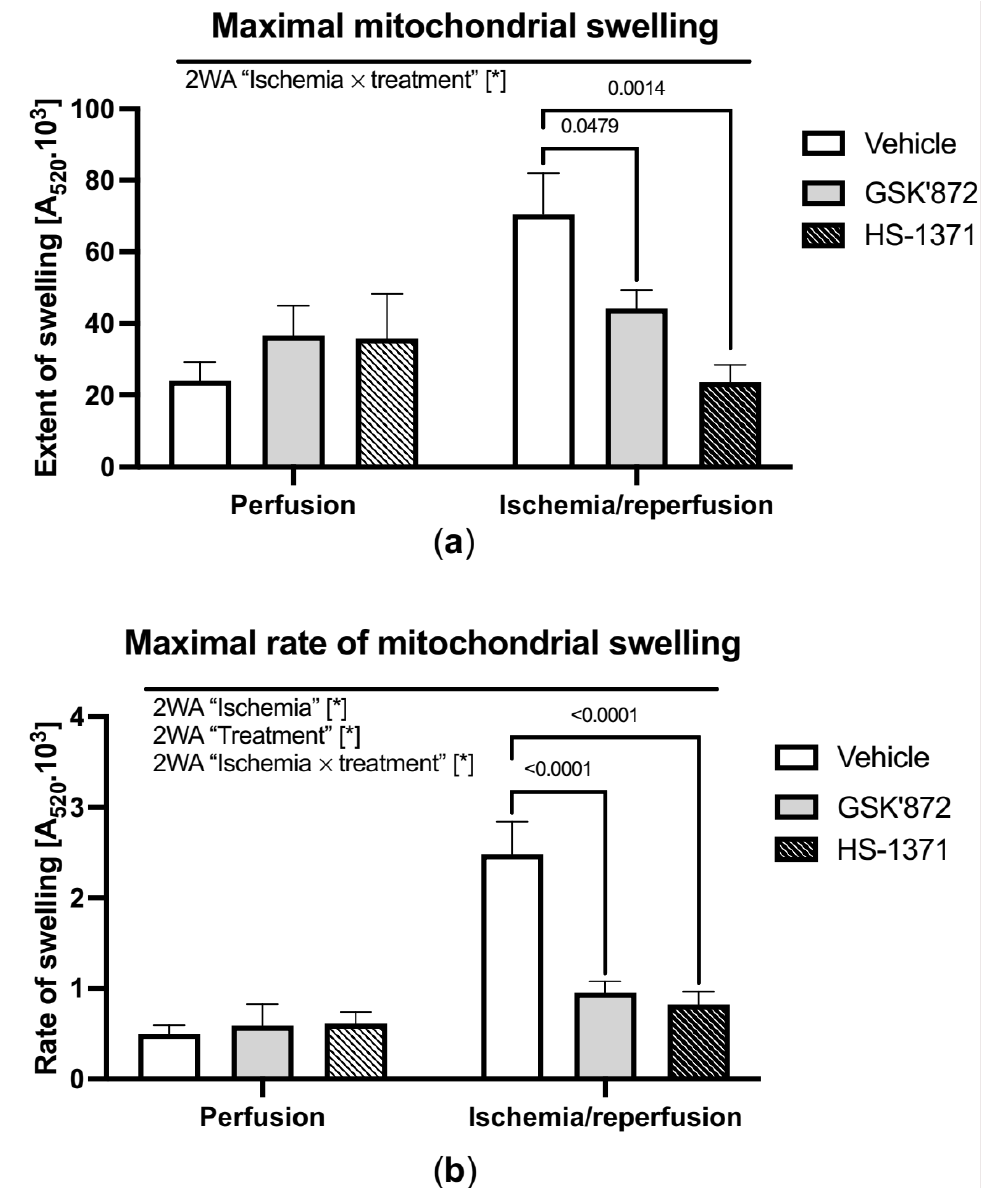
Figure 2. Analysis of the effect of RIP3 inhibition on mitochondrial swelling. ( a ) Maximal mitochon- drial swelling evaluated as the maximum decrease in A520 after calcium addition to de-energised mitochondria; ( b ) maximal rate of mitochondrial swelling evaluated as the rate of decrease in A520 in the first 5 s after calcium addition to de-energised mitochondria. Data are presented as mean ± SEM; * p < 0.05. 2WA—two-way ANOVA; “Ischemia”—presence of ischemia/reperfusion; “Treatment”— presence of GSK’872 or HS-1371; “Ischemia × treatment”—interaction of the two